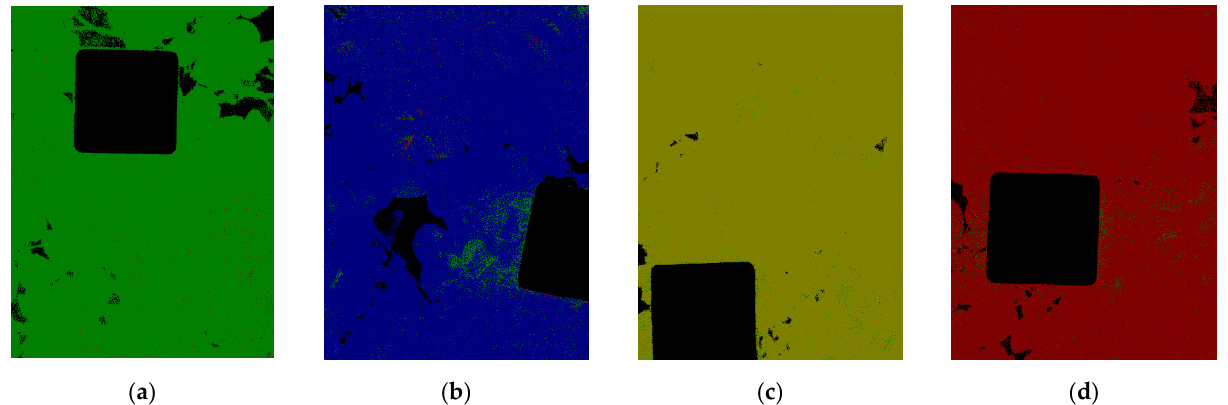
Figure 10. XGBoost classification of ( a ) image of a control plant, ( b ) image of a plant with light stress, ( c ) image of a plant with moderate stress, ( d ) image of a plant with severe stress.